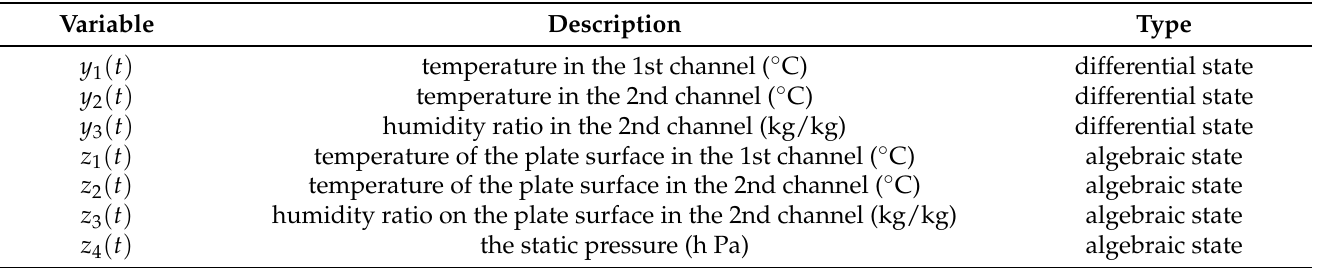
Table 1. The physical interpretation of the state variables in the model of a counter-flow